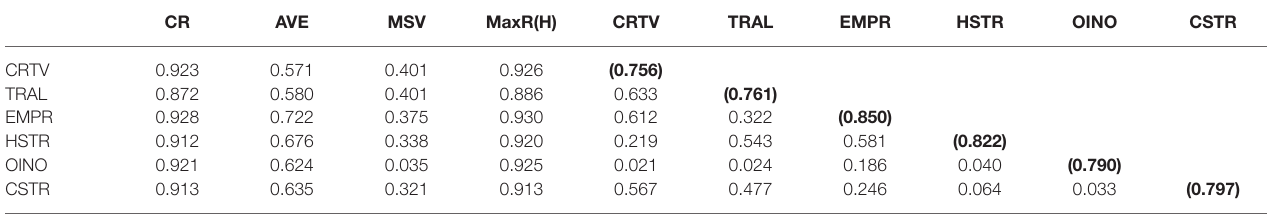
TABLE 3 | Discriminant validity and correlation index summary.